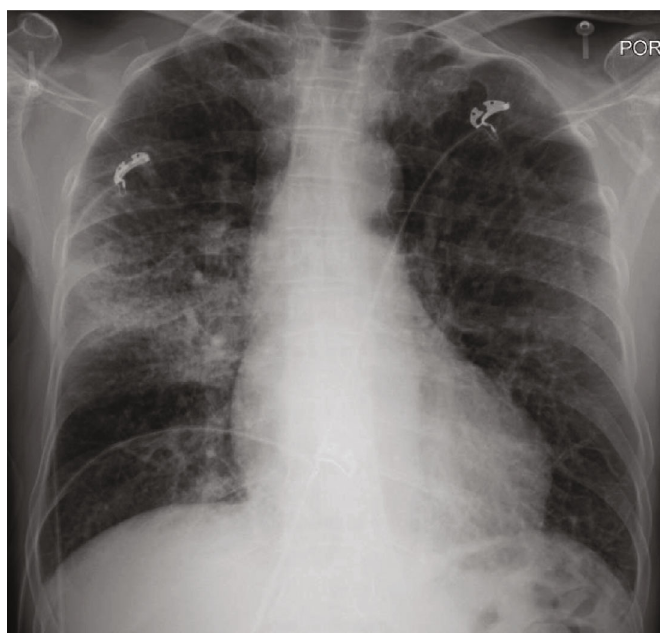
Figure 7: Chest X-ray showing interval development of right middle lobe airspace opacity concerning for pneumonia. There are di ff usely increased interstitial markings, which may be seen with mild pulmonary